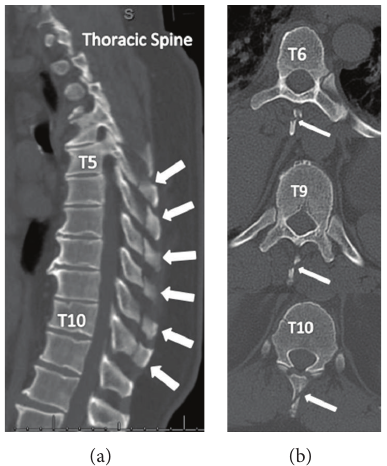
Figure 1: (a) Sagittal computed tomography (CT) image demon- strating thoracic spinous process fractures (arrows) spanning from T5 to T10. (b) Axial CT showing select (T6, T9, and T10) spinous process fractures (arrows). No evidence of vertebral body or intralaminar extension is noted.